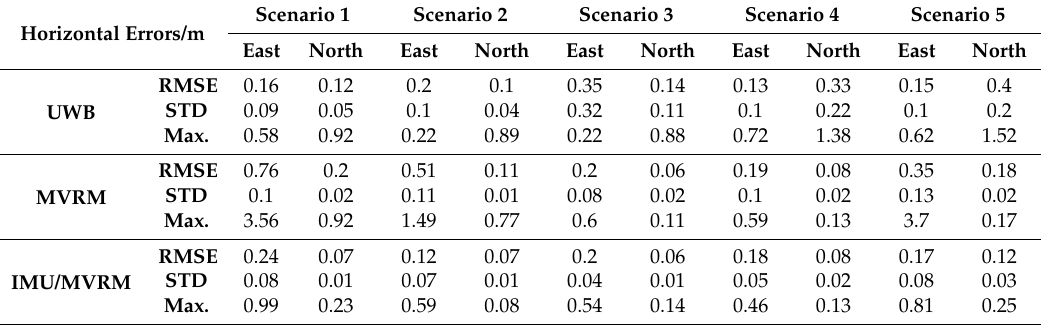
Figure 17. The horizontal trajectory in pedestrian scenario. ( a ) The pedestrian blocked the view of the camera from seeing the test person at the marker 10th and failed to detect the person; ( b ) the pedestrian blocked little view of the camera from seeing the test person near the marker 21st, and succeed to detect but caused larger image height errors. Table 3. The horizontal positioning